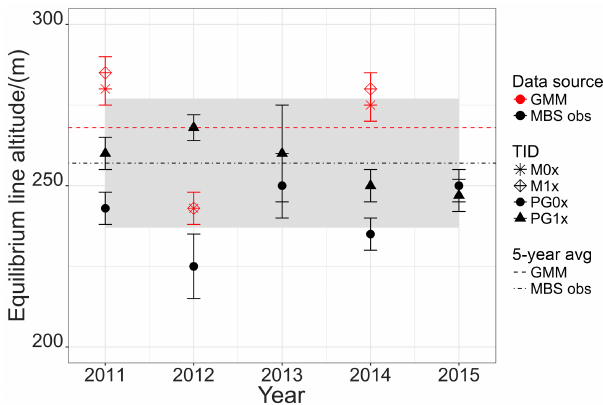
Figure 16. Equilibrium line altitude calculated from observations at transects PG0 x (black, solid circle) and PG1 x (black, solid tri- angle) and from GMM simulation (M) output at transects pixels PG0 x (red, solid circle) and PG1 x (red, solid triangle) for the time period 2010 to 2016. The 5-year average ELA from MBS obser- vations (MBS obs) and from GMM model results (GMM) are dis- played with the grey shading indicating the uncertainty around the average observed ELA.